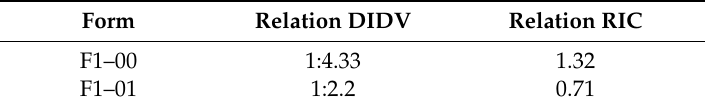
Table 5. Results for the relations data indispensable / data verification (DIDV) and relation information content (RIC) of the forms F1–00 and F1–01.